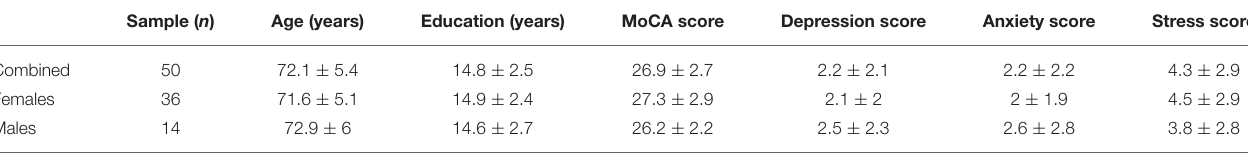
TABLE 1 | Demographical characteristics of